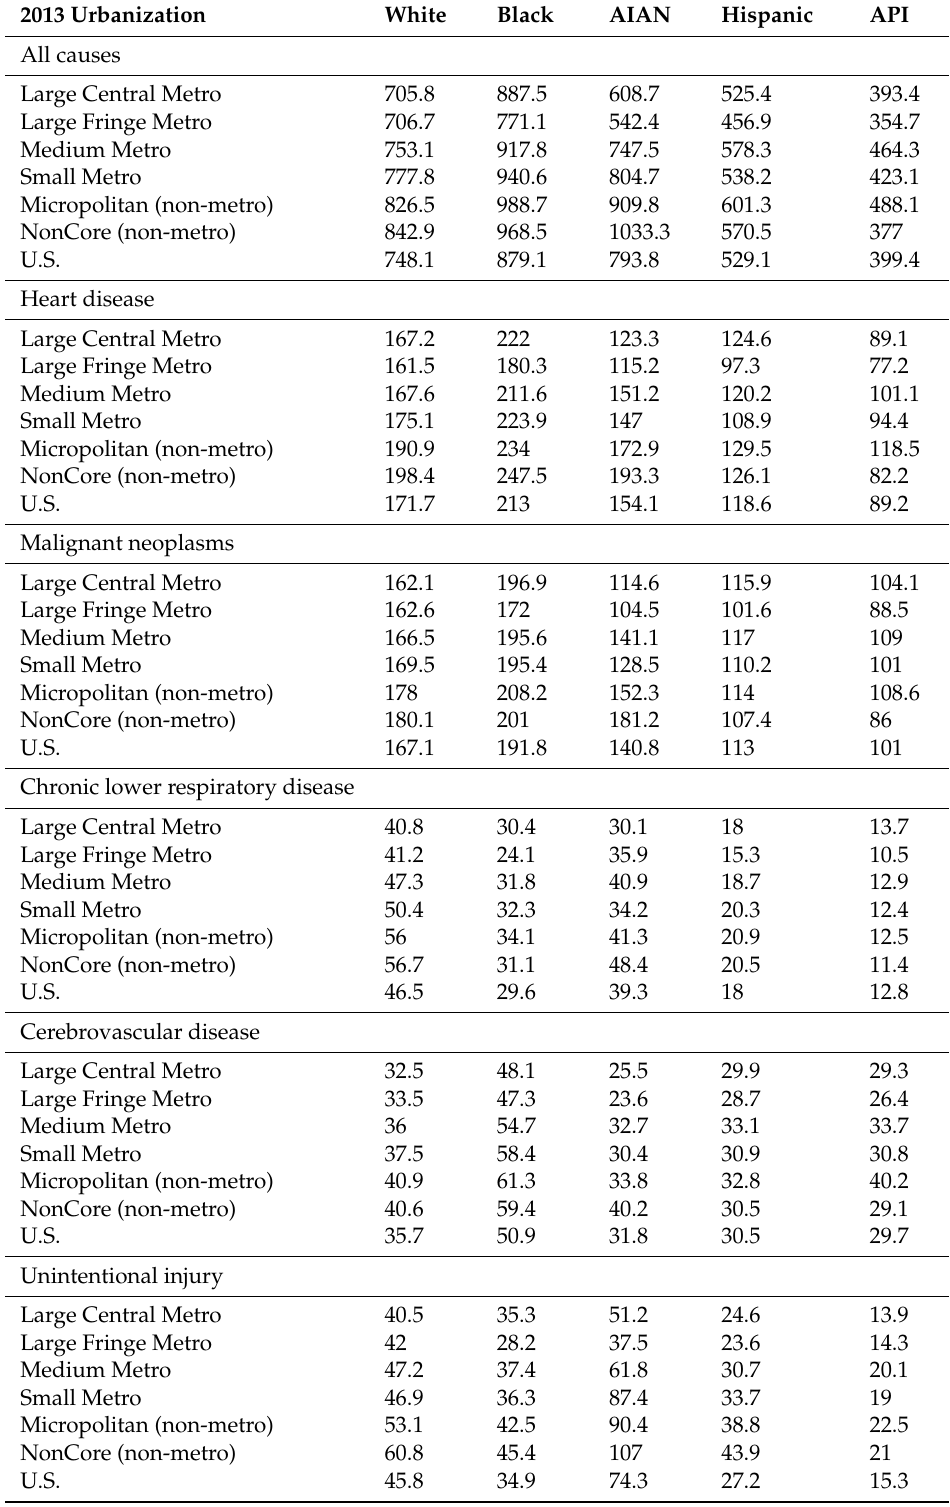
Table 7. Age adjusted mortality rates per 100,000 population for the five leading causes of death by race/ethnicity * groups and Urbanization—National Vital Statistics System, United States,